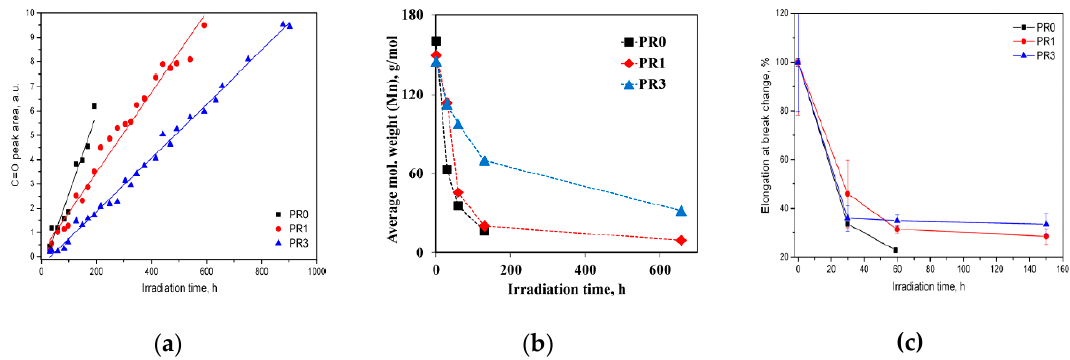
Figure 15. ( a ) Carbonyl functionalities, ( b ) molecular weight variation, and ( c ) elongation at break of neat PLA (PR0) and PLA containing 1 and 3 wt.% of R (PR1 and PR3) as a function of the irradiation time [82], Reproduced with permission from Agustin-Salazar S, ACS Sustainable Chem. Eng.; published by ACS Publications, 2014.